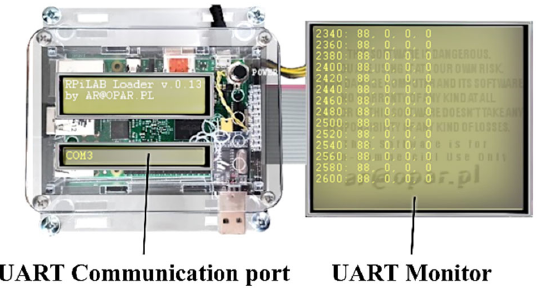
Figure 5. The RPILAB Loader—a dedicated programmer and monitor using UART communication.